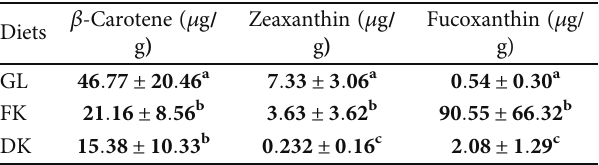
Table 2: The quantity of carotenoids in di ff erent diets ( Mean ± SD ). β -Carotene ( μ g Diets